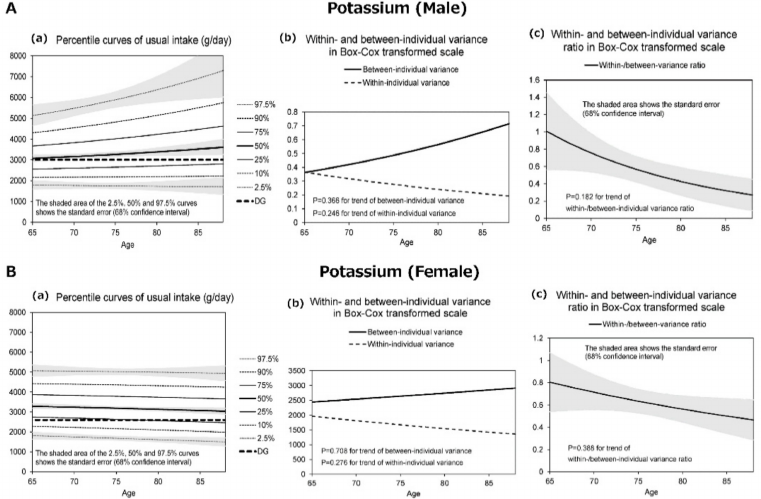
Figure 3. The percentile curves of usual nutrient intake of potassium by age (male and female).